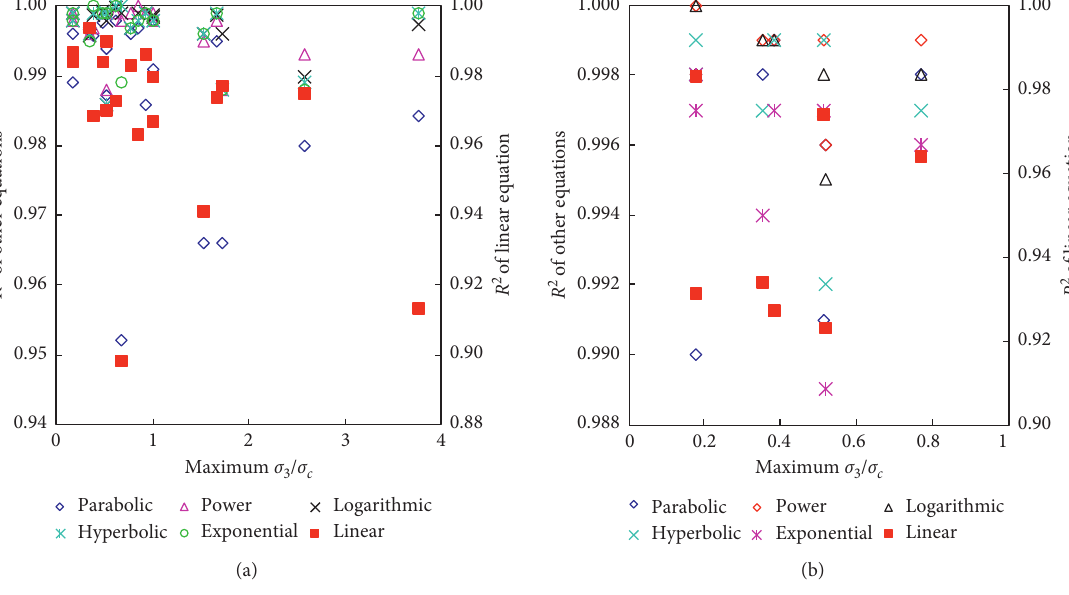
t ) t was not included. (b) ( σ t ) t was